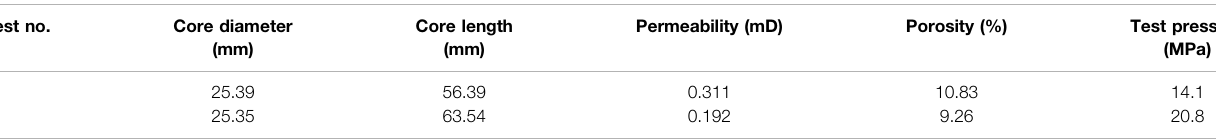
TABLE 1 | Physical properties for the core samples with different test pressures at 46.4 ° C. Test no.